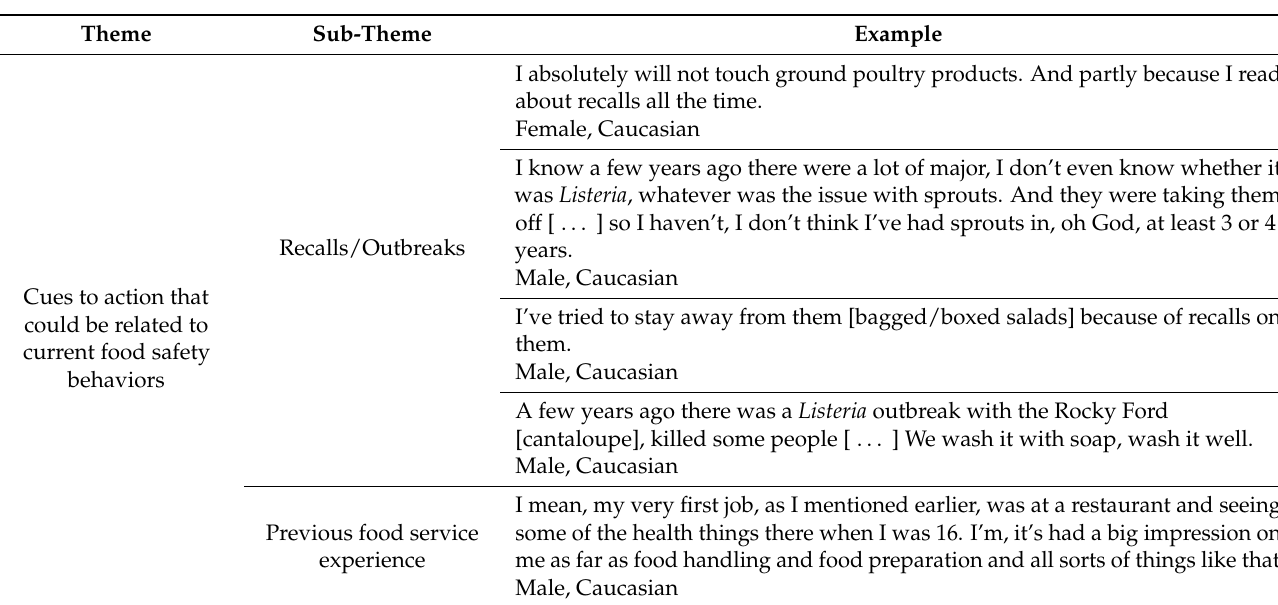
Table 6. Supporting quotes from a thematic analysis of the focus group discussions related to the Health Belief Model construct, cues to